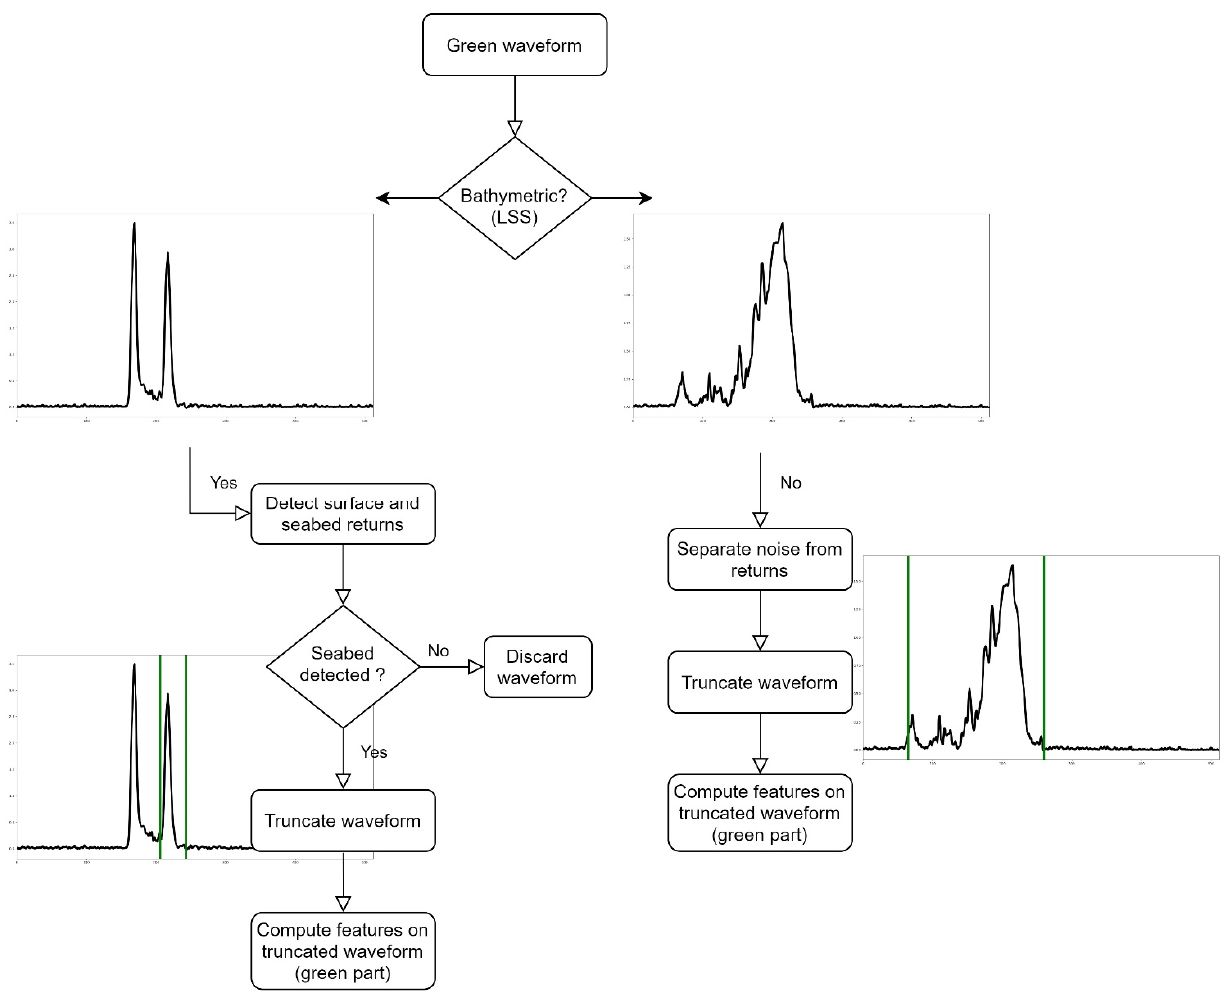
Figure 7. Waveform processing method flowchart and illustration on two different waveforms: one acquired over the sea, the other over land.